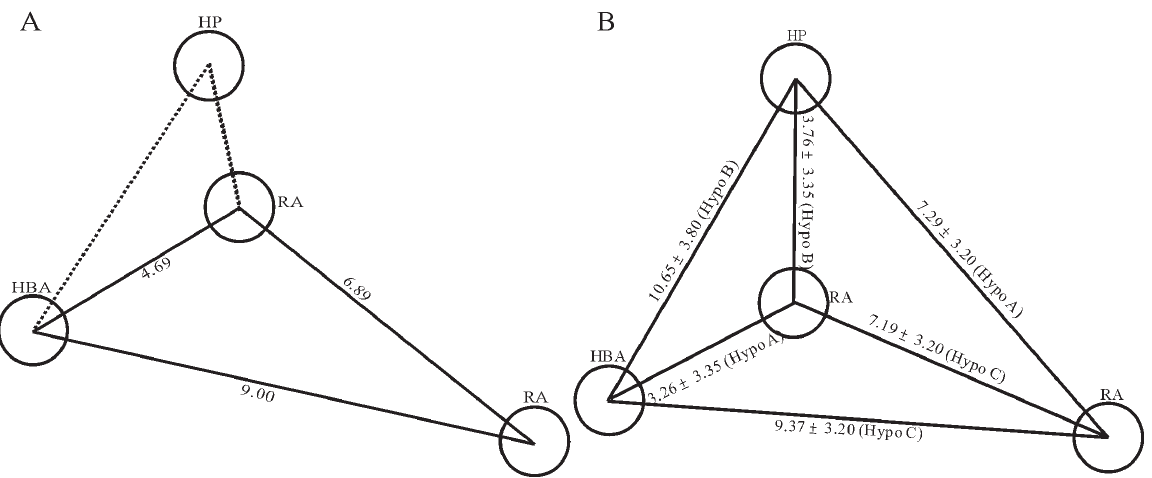
Figure 12. Model proposed by Sim etal . and excerpted model of this study. Geometrical relationships in the pharmacophore models (A) proposed by Sim et al . and (B) excerpted from the PhE in this study. The interfeature distances are measured in A ˚ ngstroms.